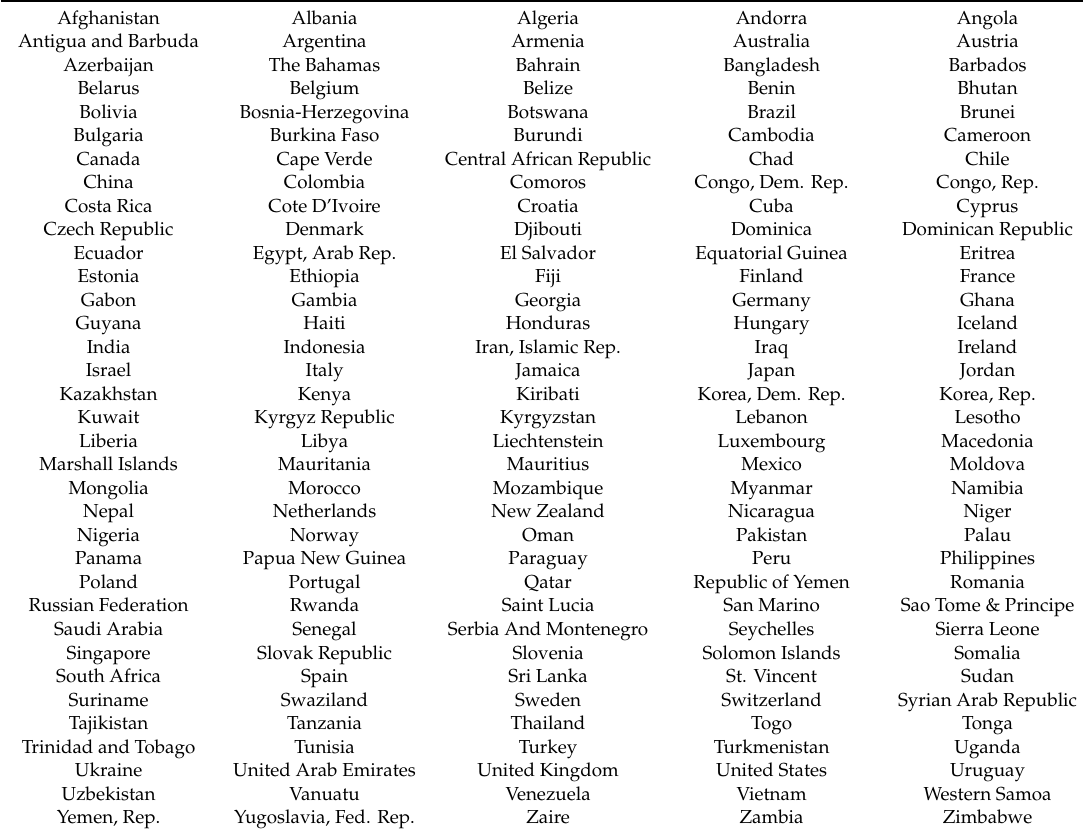
Table A1. List of countries included in the empirical analysis.